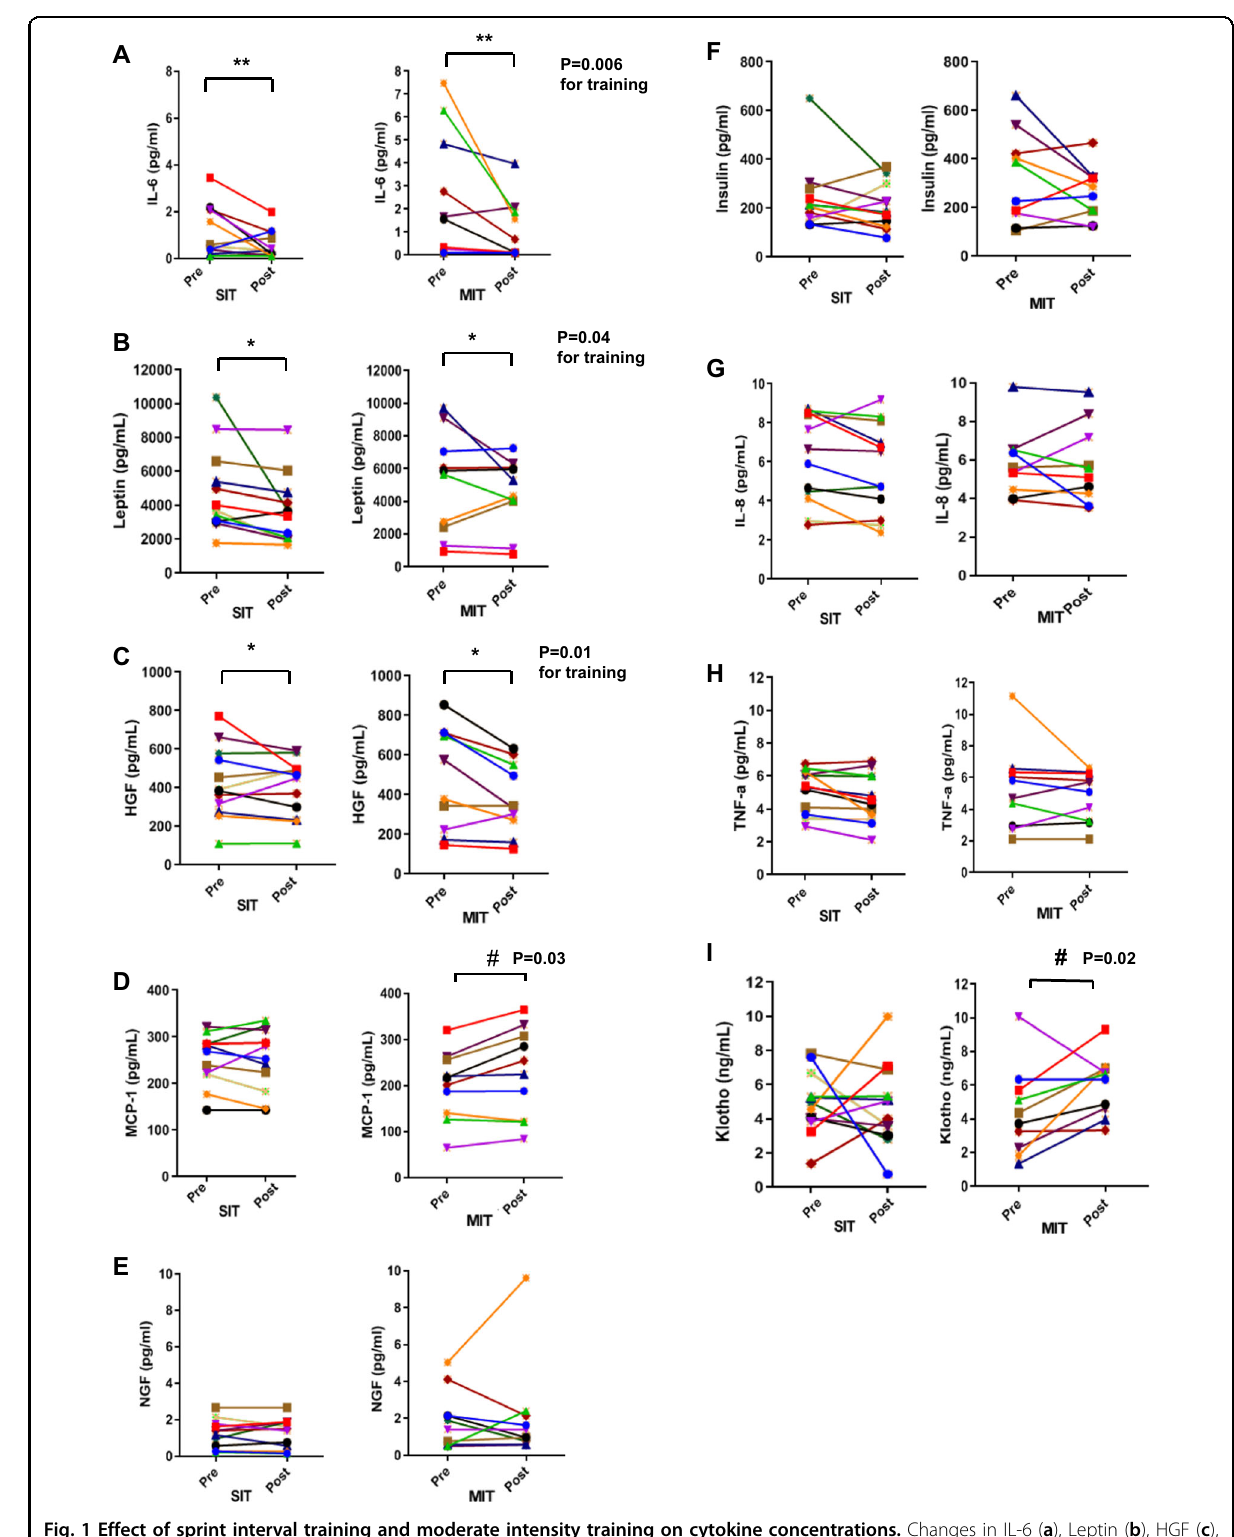
Fig. 1 Effect of sprint interval training and moderate intensity training on cytokine concentrations. Changes in IL-6 ( a ), Leptin ( b ), HGF ( c ), MCP-1 ( d ), NGF ( e ), Insulin ( f ), IL-8 ( g ), TNF- α ( h ), and Klotho ( i ) pre- and post-training. All concentrations are in pg/ml, except for Klotho, which is ng/ ml. * P < 0.05 for differences pre-training and post-training. ** P < 0.01 for differences pre-training and post-training. # P < 0.05 for differences between exercise training intensities. Data for NGF, IL-6, Insulin and TNF- α were log transformed. N = 9 – 12 per